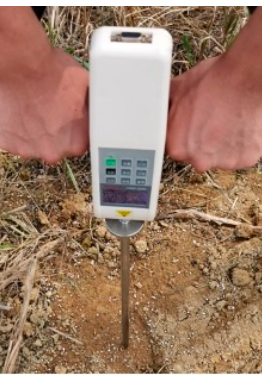
Figure 2. Portable electronic soil penetration resistance tester.